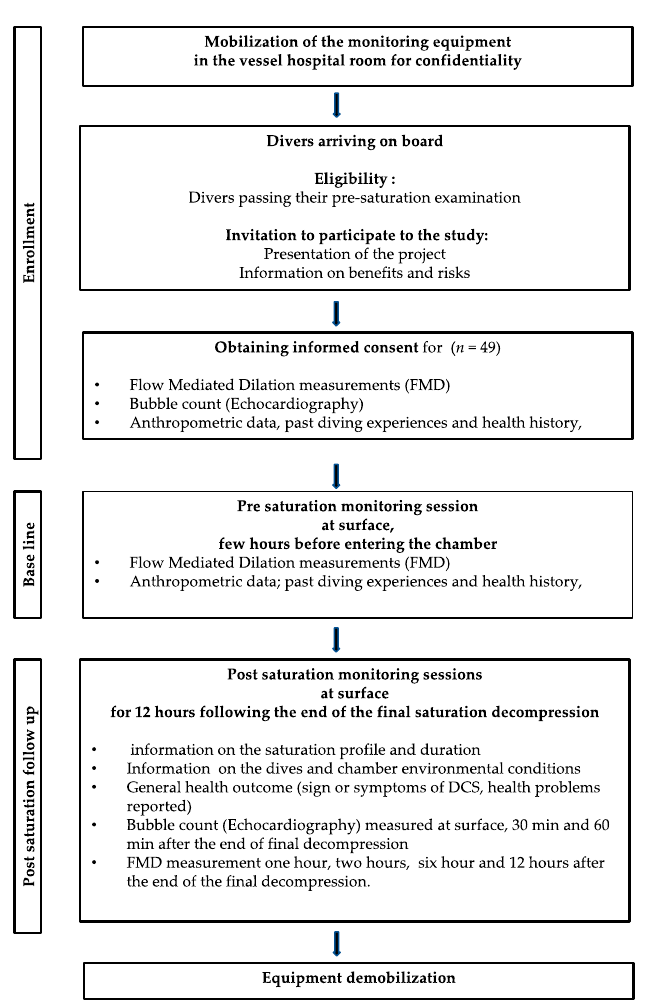
Figure 3. Experimental flowchart.